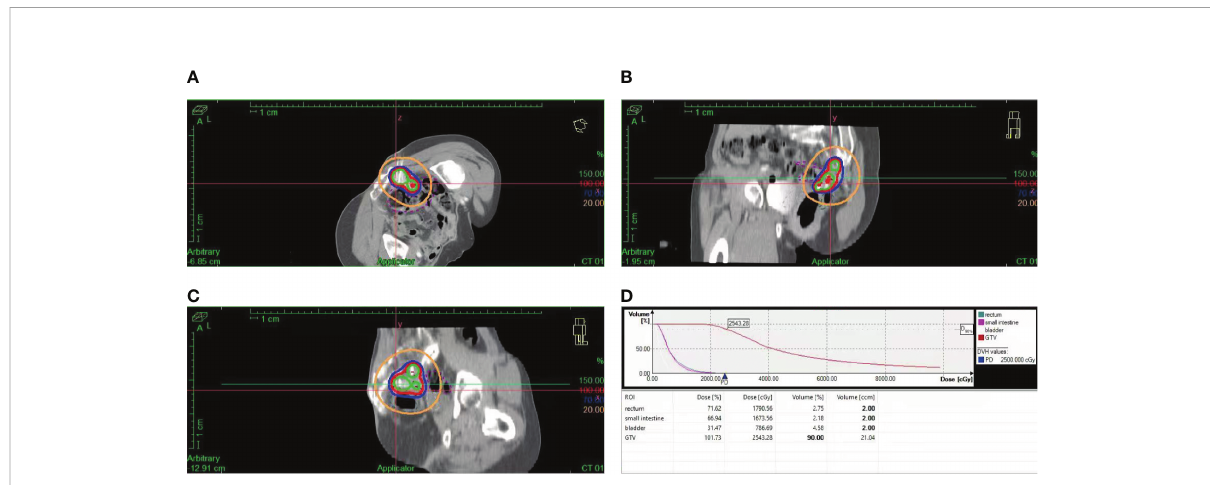
FIGURE 3 Three-dimensional conformal dose assessment for interstitial BT. (A) . Cross-sectional image. (B) . Sagittal image. (C) . Coronal image. (D) . Dose- volume histogram